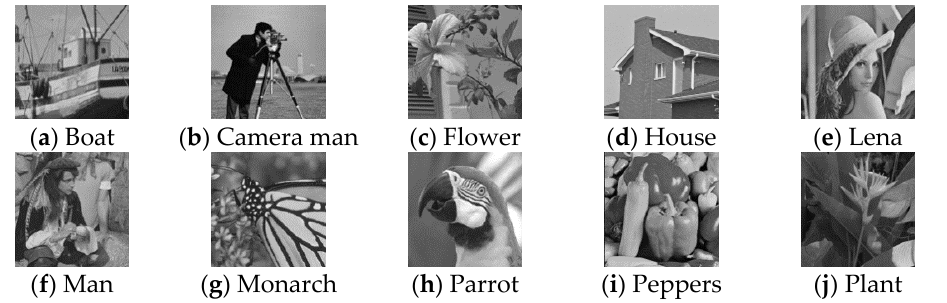
Figure 3. The 10 commonly used images for our deblurring testing. Table 1. The average PSNR of 10 images in Figure 3 by three methods.